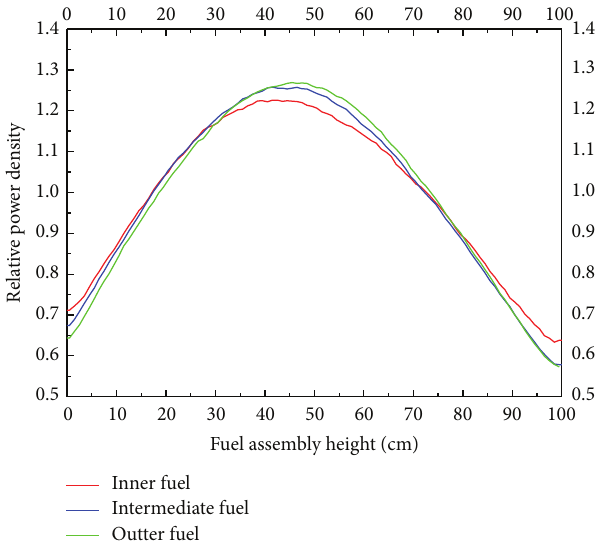
Figure 6: Assembly axial power distribution.